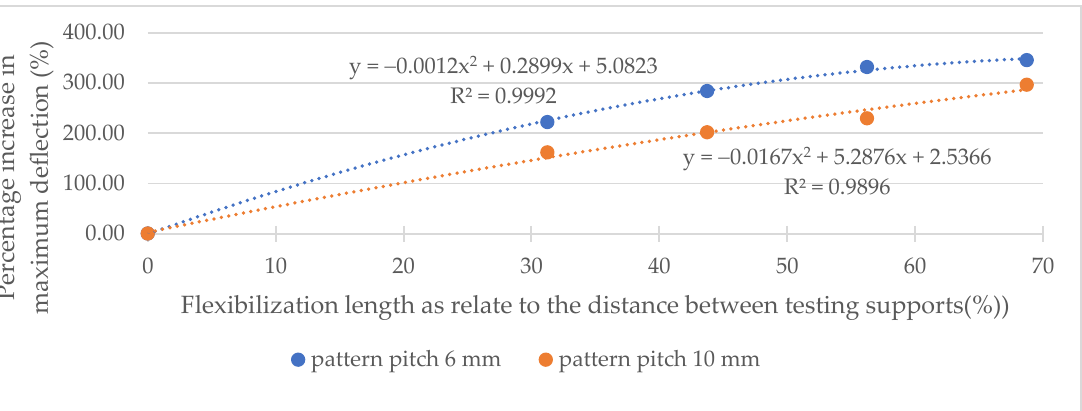
Figure 16. Correlations between percentage change in the maximum deflection with changes in the flexibilization length, for two values of the kerfing pitch.